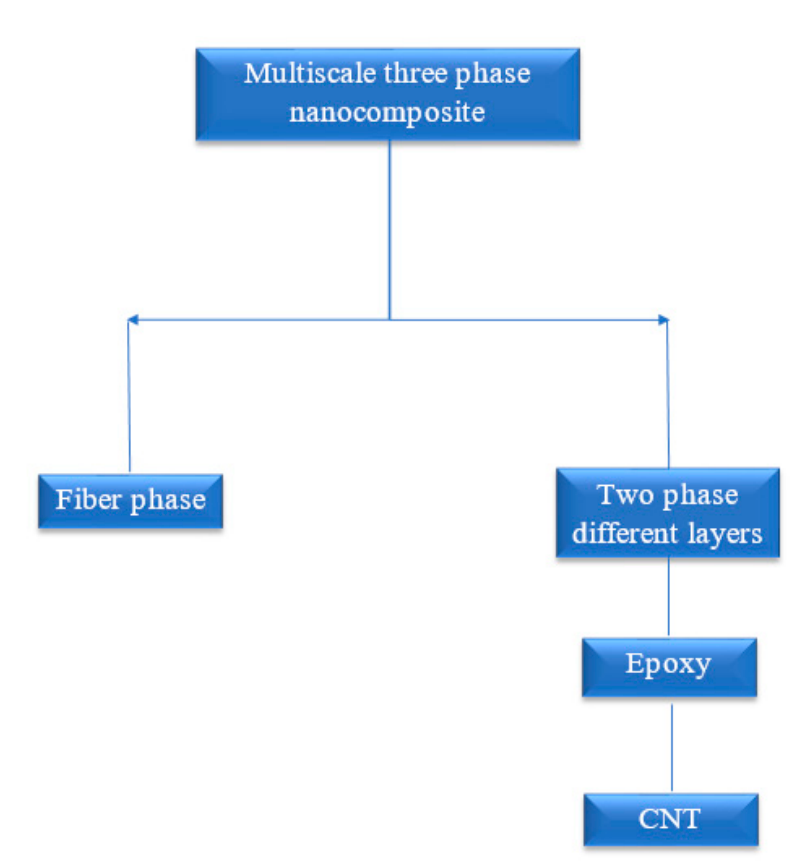
Figure 2. Overview of multiscale hybrid composite.